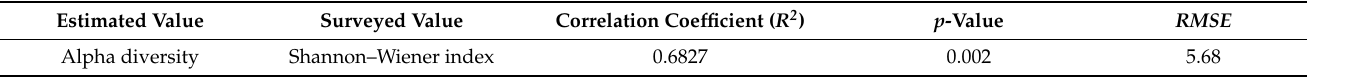
Table 2. Summary of linear regressions for Shannon–Wiener index with spectral